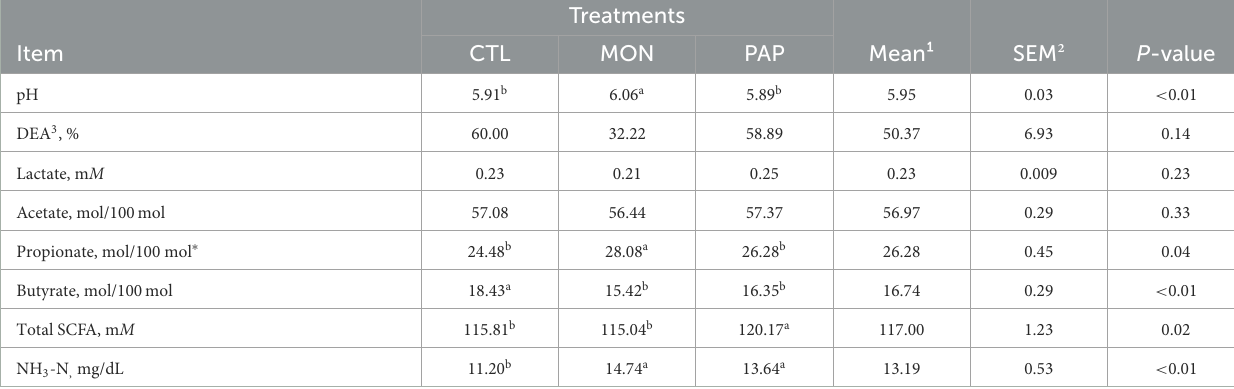
TABLE 4 Ruminal fermentation variables of cows induced to acidosis and receiving polyclonal antibodies preparations (PAP) or monensin (MON).